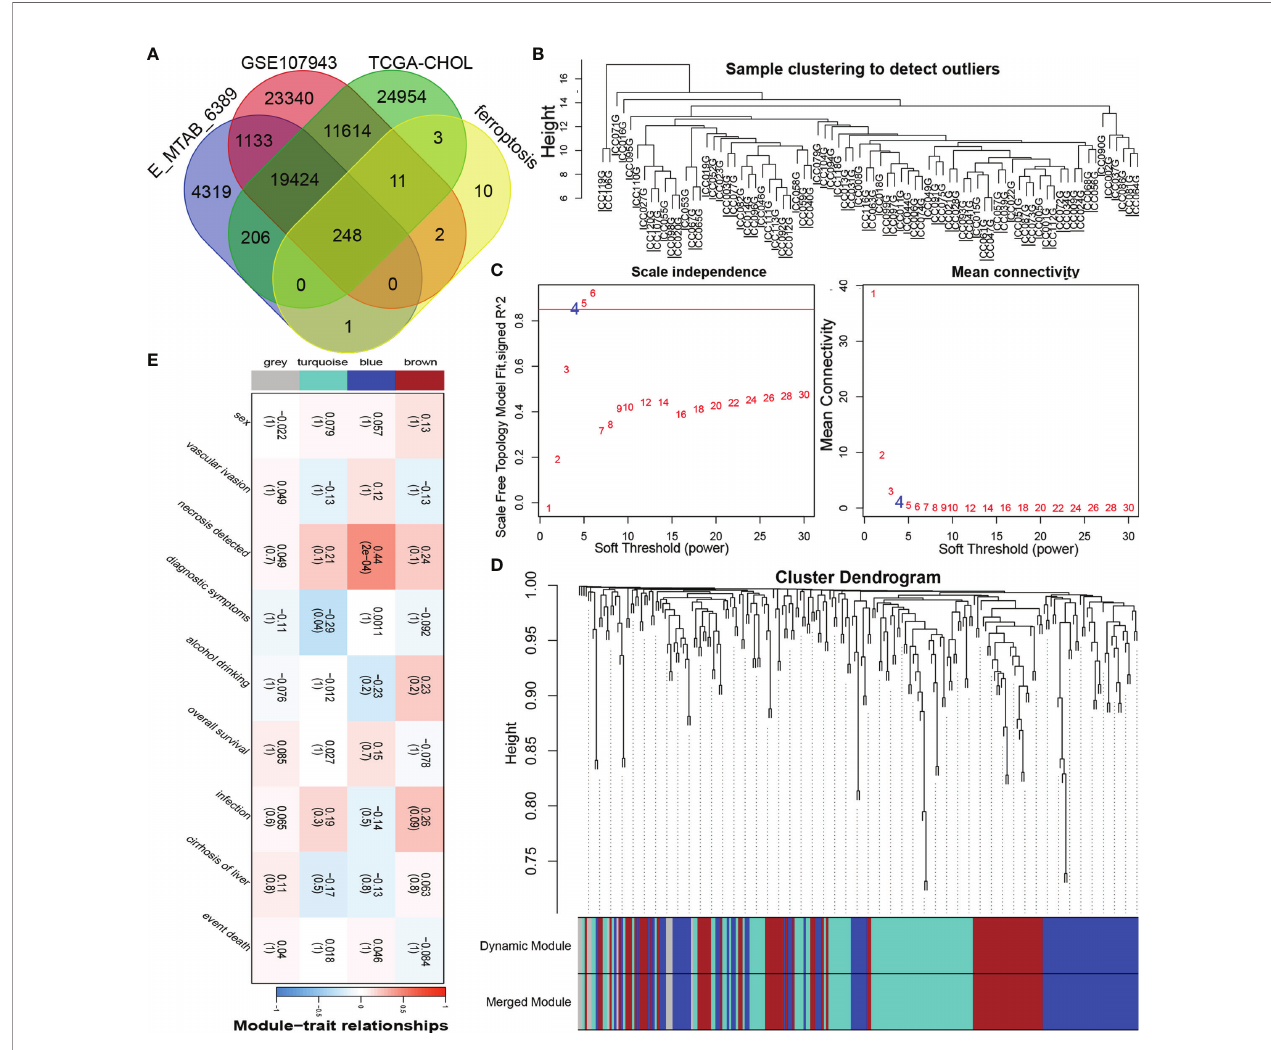
FIGURE 2 | Construction of the coexpression modules of ferroptosis genes related to the clinical characteristics of cholangiocarcinoma. (A) Venn diagram of FRGs in cholangiocarcinoma. (B) Sample clustering of FRGs. (C) The soft threshold of the FRG module was de fi ned by scale independence and mean connectivity. (D) Correlations between sample clustering and modules. (E) Relationships between the FRGs and clinical